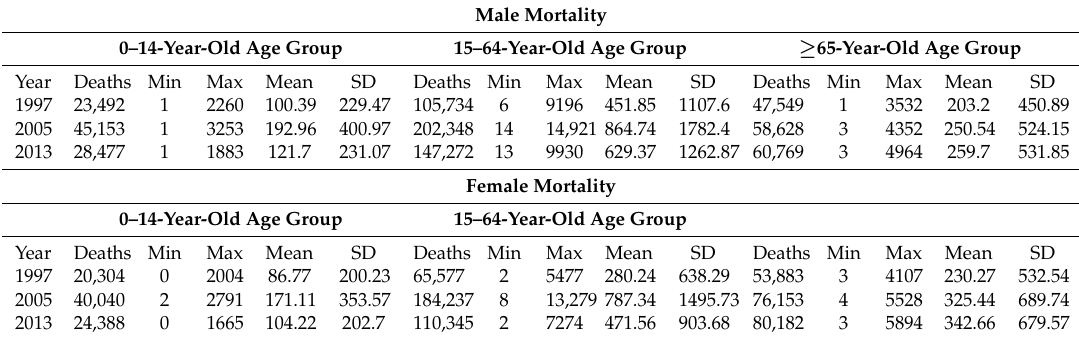
Table 1. Distribution of deaths by gender and age groups per municipality in South Africa, 1997, 2005, and